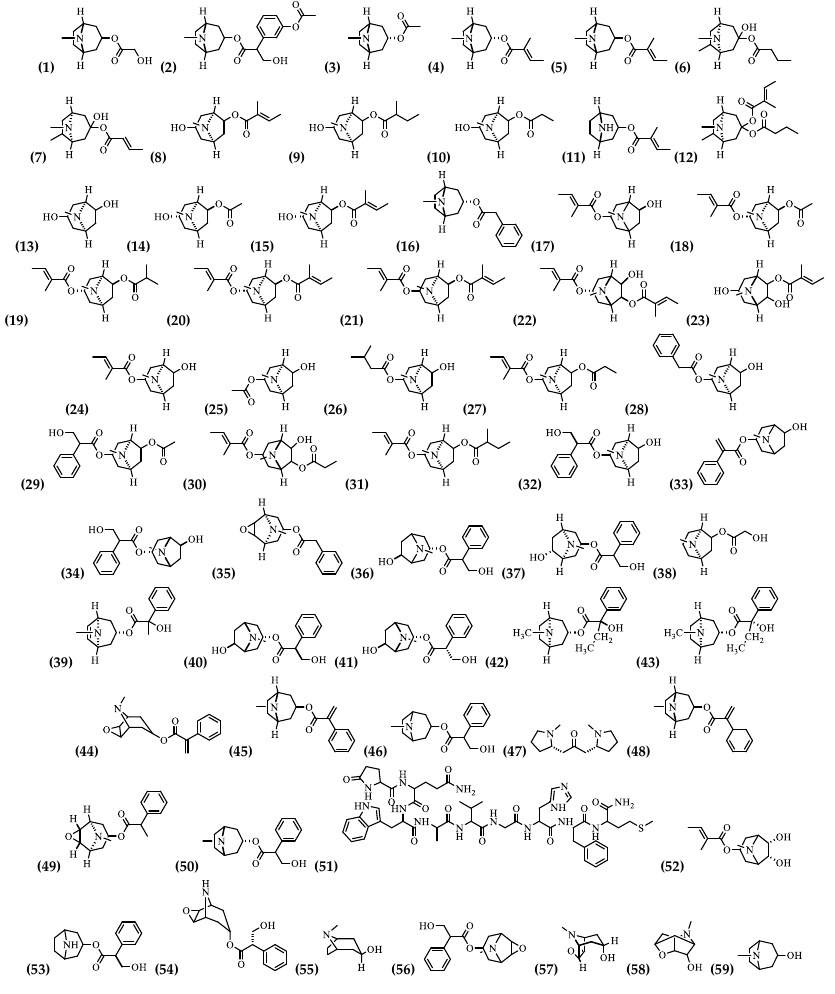
Figure 3. Structure of alkaloids from Brugmansia suaveolens.